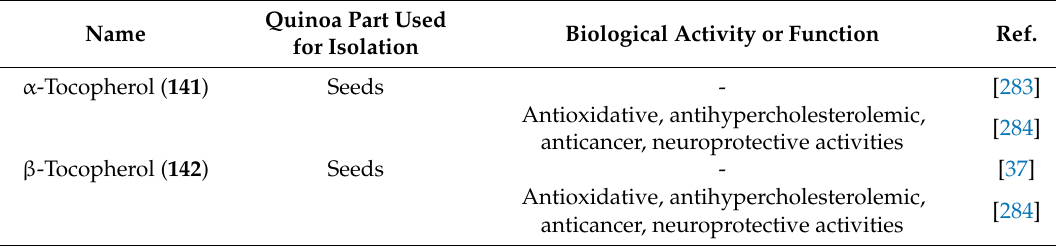
Table 18. Meroterpenoids and their biological activities or